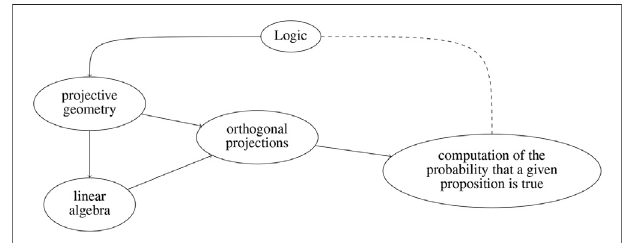
FIGURE 1 | The relations between logic, projective geometry, linear algebra, orthogonal projections, and the computation of